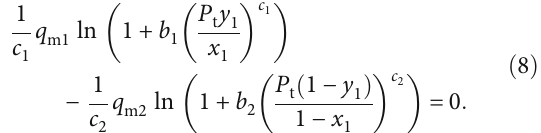
relative to CH at 2 4